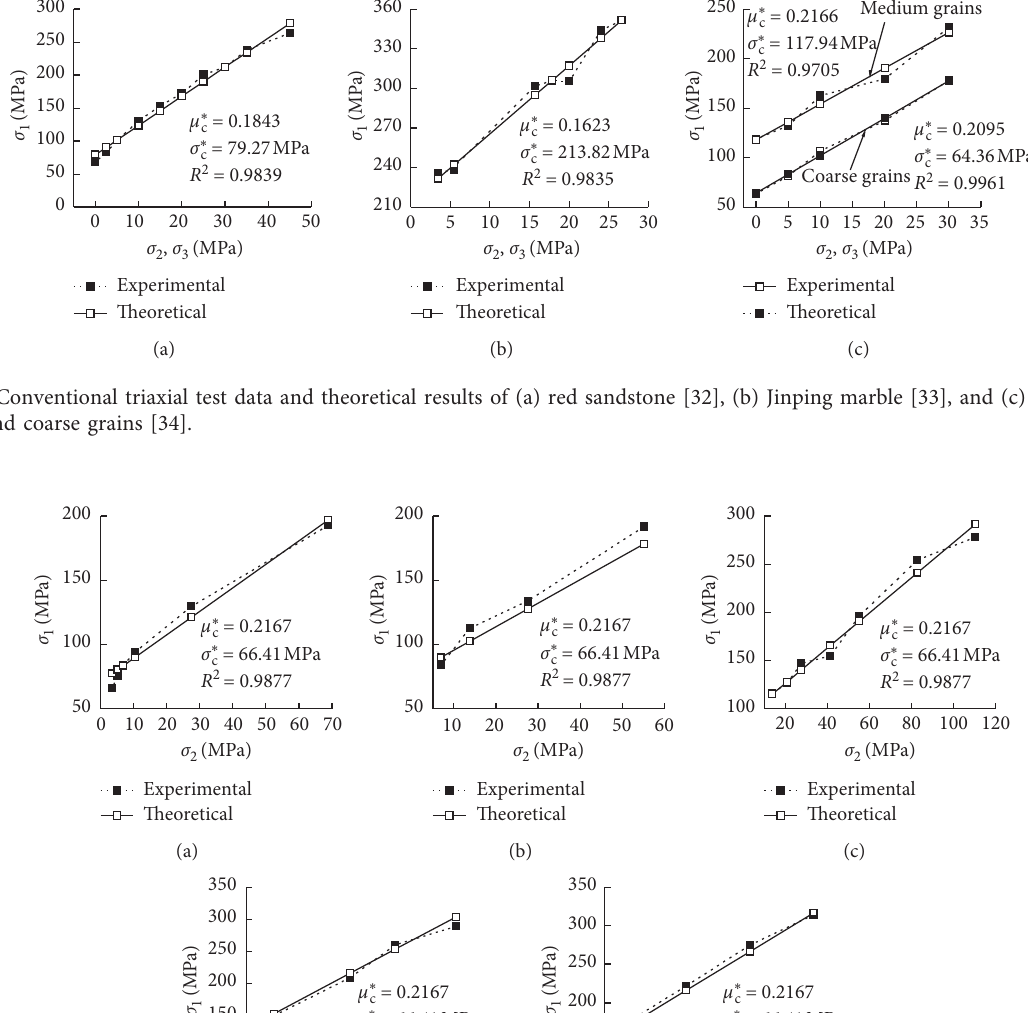
� 3.45MPa. (b) σ � 6.89MPa. 3 3